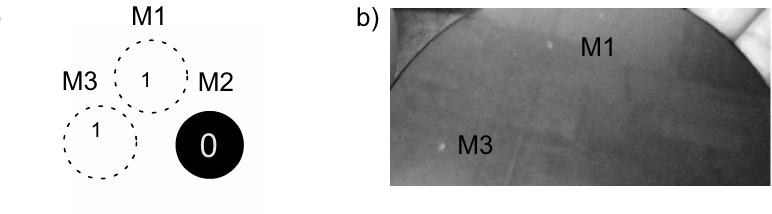
Figure 7. Stokesmeter pattern at Witness Plate 2 (Figure 1 ( a ) Simulation obtained for a linear polarization ( Q = +1 ); ( b ) experimental pattern obtained on the